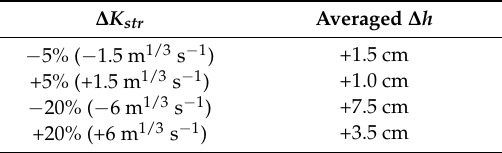
Table 1. Impact of the relative and absolute perturbation of the K str reference coefficient on the river depths, h